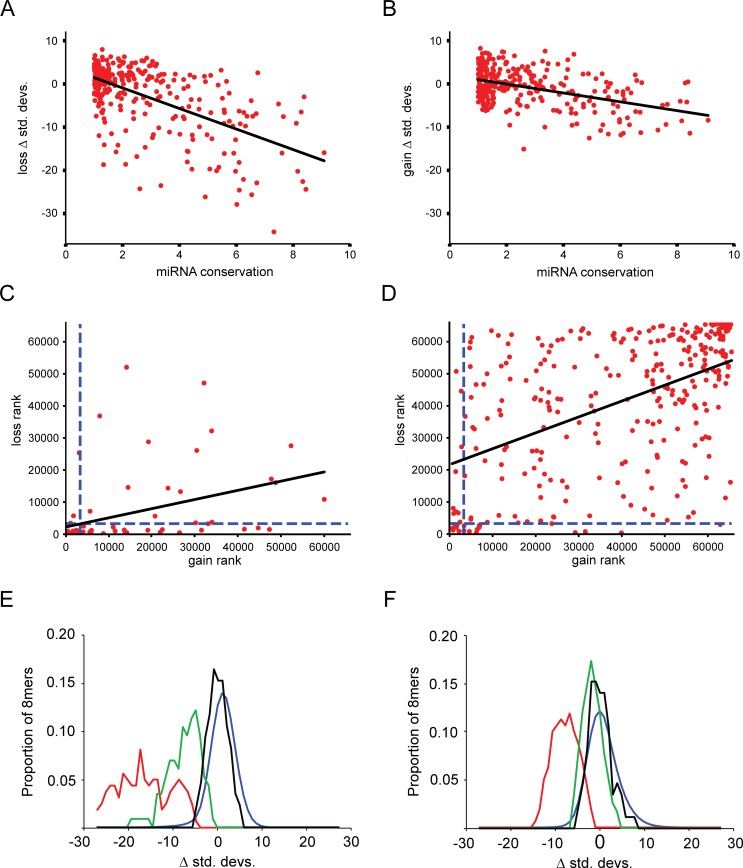
Selection against gain and loss of miRNA target sites correlates with miRNA age.The age of each miRNA, as measured by the summed branch length across which each full length miRNA is conserved (x-axis measured in genome-wide substitutions per site, larger numbers represent greater conservation), compared against the strength of selection acting on each target site (y-axis, standard deviations below the mean of simulated values), for losses and gains of sites (A and B, respectively). (C, D) miRNA gain ranks of individual miRNAs relative to all 8mers (x-axis, ranked by standard deviations above or below the mean of simulations) versus miRNA loss ranks relative to all 8mers (y-axis), analyzed for 75 deeply conserved miRNAs (C) and 299 moderately conserved miRNAs (D). miRNAs considered to be under negative selection are those below a rank of 3277 (5% of 65,536, dashed lines). (E, F) Skew of proportion of miRNA loss ranks (E) and gain ranks (F) at a given number of standard deviations from simulated values for 75 deeply conserved miRNAs, as described in Fig 2, separated into those in miRNA group 1 (constrained below 5% threshold for gains and losses in panel C; in red), group 2 (constrained for losses but not gains; in green), and group 3 (not constrained for gains nor losses; in black) as compared to the proportions of all 65,536 8mers (blue).